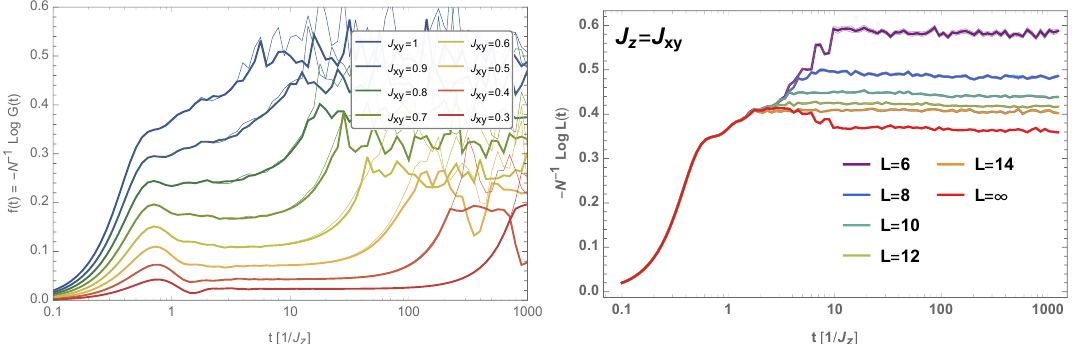
Figure 3: Left: The nonequilibrium free energy f ( t ) = − 1 = 1, N = 20000, and system sizes L = 6 (thin lines) and L = 8 (thick fixed J z mc = L = L . No dynamical phase transition is observed in the short lines), where L x y times before a steady state plateau emerges. A prethermalization regime appears with increasing anisotropy. Right: The nonequilibrium free energy for the isotropic = J case J as a function of system size L , averaged over N z x y configurations. I extrapolated these results to L = ∞ , which still does not show any signatures of nonanalytic